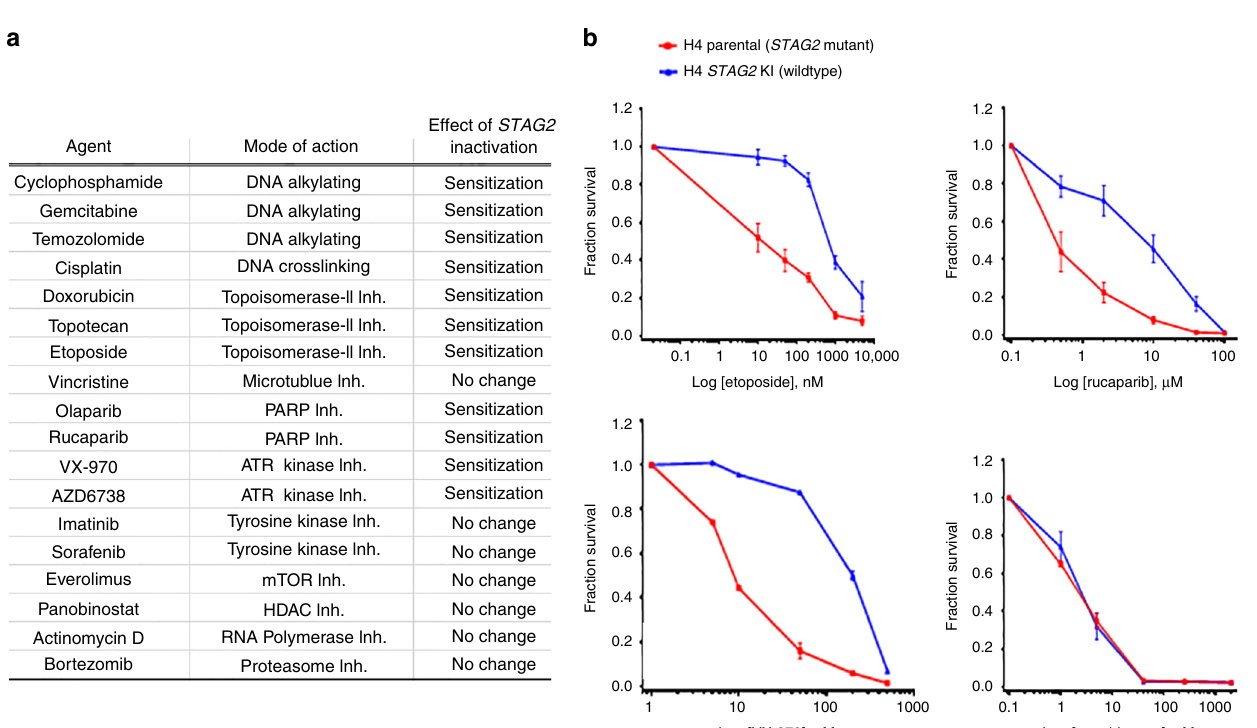
Fig. 7 STAG2 de fi ciency in human cancer cells creates a synthetic lethality with DNA double-strand break repair factors and increased sensitivity to ionizing radiation. a Quantitation of survival from shRNA synthetic lethality screen in STAG2 isogenic H4 glioblastoma cells (parental = STAG2 mutant, STAG2 KI = wildtype). Each data point is the mean of 8 replicates from 2 independent experiments, and error bars show standard error of the mean. b Representative phase contrast images of STAG2 isogenic H4 glioblastoma cells showing synthetic lethality of STAG2 inactivation with shRNA depletion of the non- homologous end joining factor DNA-PKcs. c Quantitation of survival from shRNA synthetic lethality screen in STAG2 isogenic RPE sh TP53 cells. Each data point is the mean of 8 replicates from 2 independent experiments, and error bars show standard error of the mean. d Representative phase contrast images of STAG2 isogenic RPE sh TP53 cells showing synthetic lethality of STAG2 knockout with shRNA depletion of the non-homologous end joining factor DNA- PKcs, but not the base excision repair factor DNA polymerase β . e Summary of results from shRNA synthetic lethality screen in four pairs of STAG2 isogenic human cells (H4 glioblastoma, 42MGBA glioblastoma, TC-106 Ewing sarcoma, and RPE hTERT sh TP53 ). HR, homologous recombination. NHEJ,